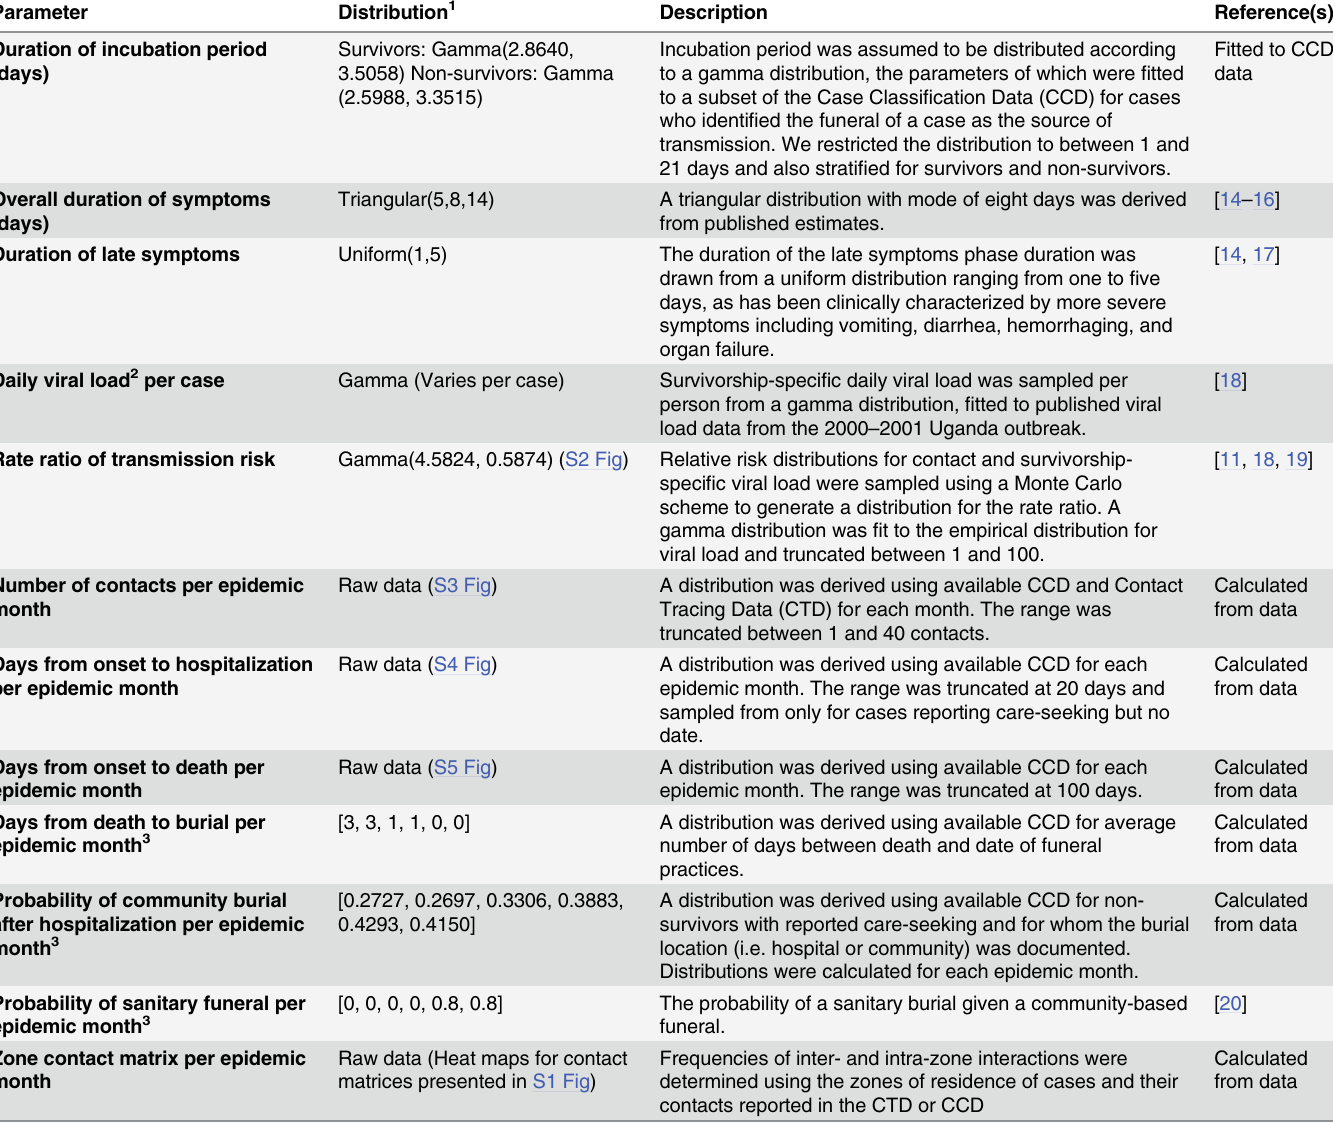
Table 1. Distributions for model